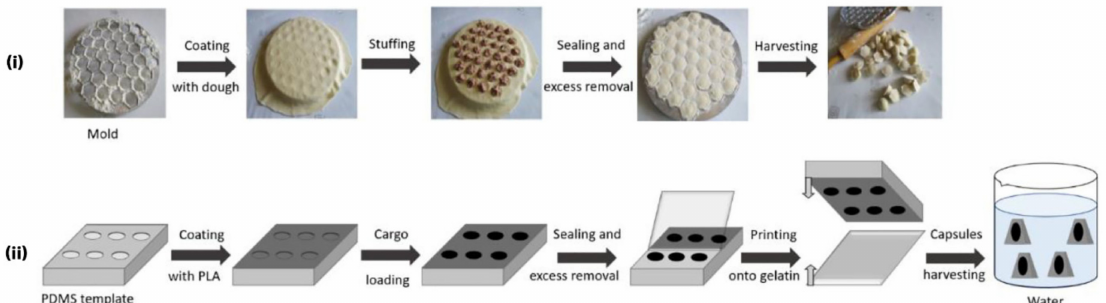
Figure 7. Schematic illustration of defined-shape microcapsules fabrication of ( i ) traditional pelmeni production process and ( ii ) PLA microcapsule harvesting in water [64].